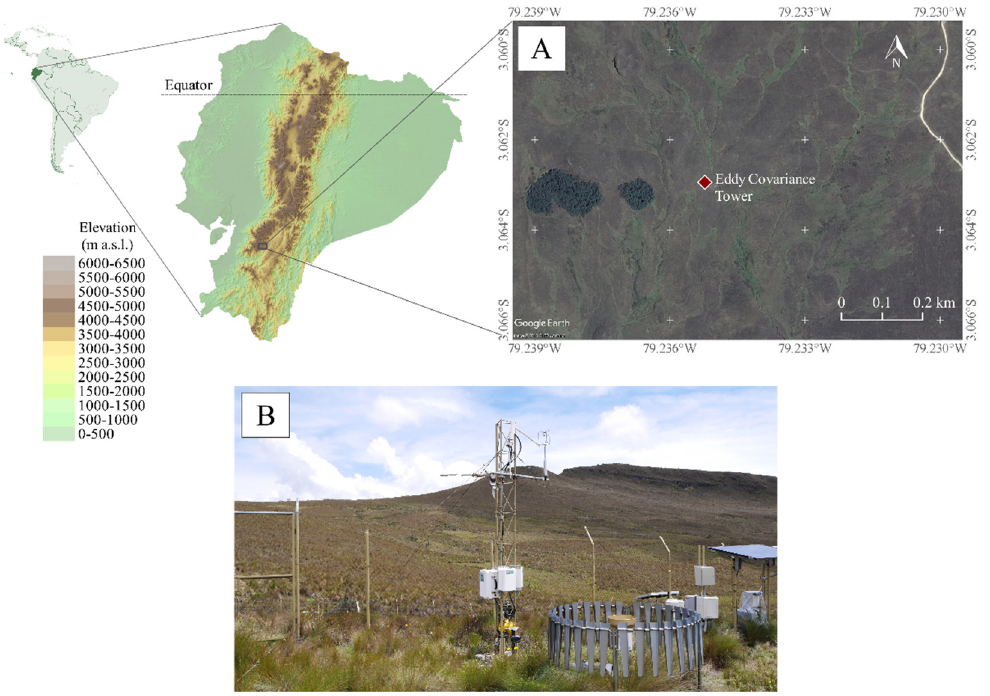
Figure 1. Study area. ( A ) Aerial view of the surroundings of the Eddy covariance tower in the Zhurucay Ecohydrological Observatory. It is observed that the main vegetation cover is tussock grass. ( B ) Eddy covariance tower installed at 3780 m a.s.l.